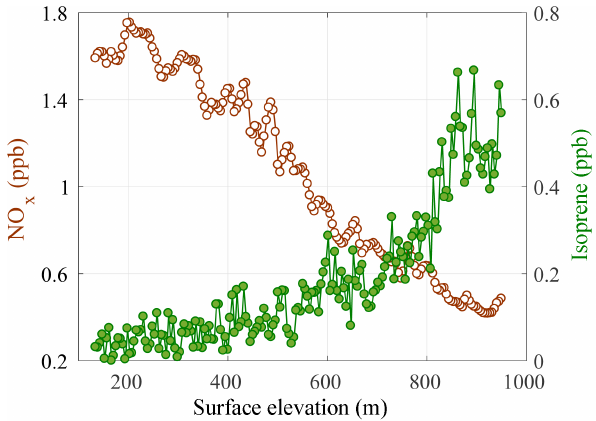
Figure 5. NO x (brown open circles) and isoprene (green filled cir- cles) measured onboard the NASA DC-8 at ∼ 10:00 LT at the Sierra Nevada western slope from a mean altitude of 130 to 1000ma . g . l . on 19 June 2016. The surface elevation is estimated by linearly in- terpolating across the total elevation